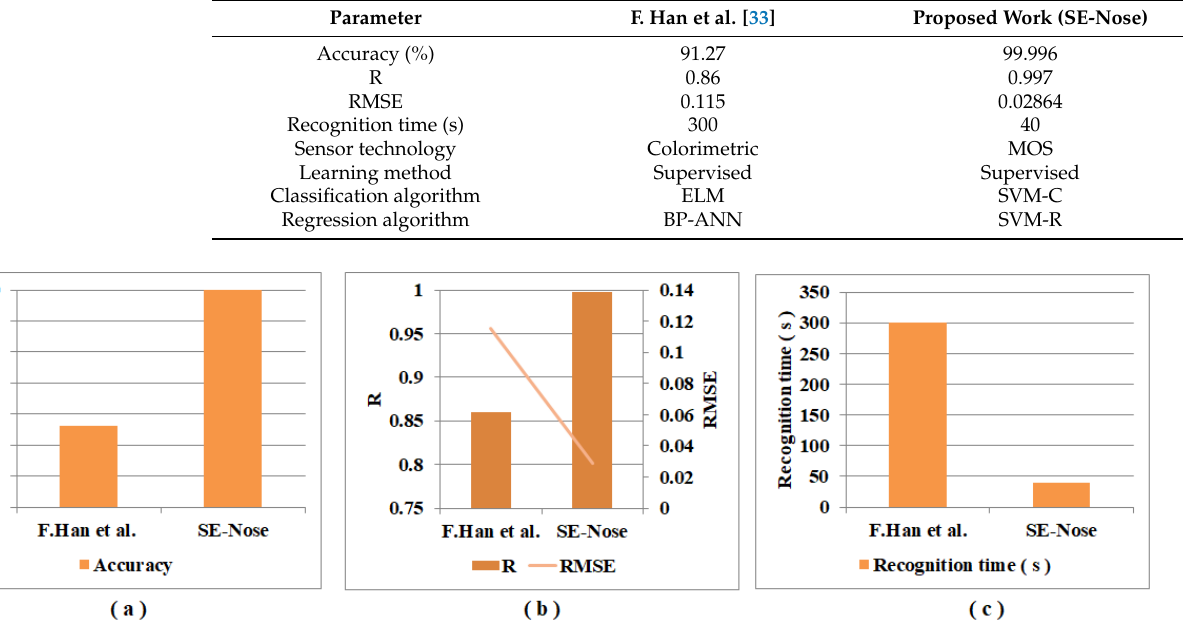
Figure 7. Graphical representation of the comparison of performance metrics: ( a ) accuracy; ( b ) R, RMSE; and ( c ) recognition time of F. Han et al. [33] and the SE-Nose